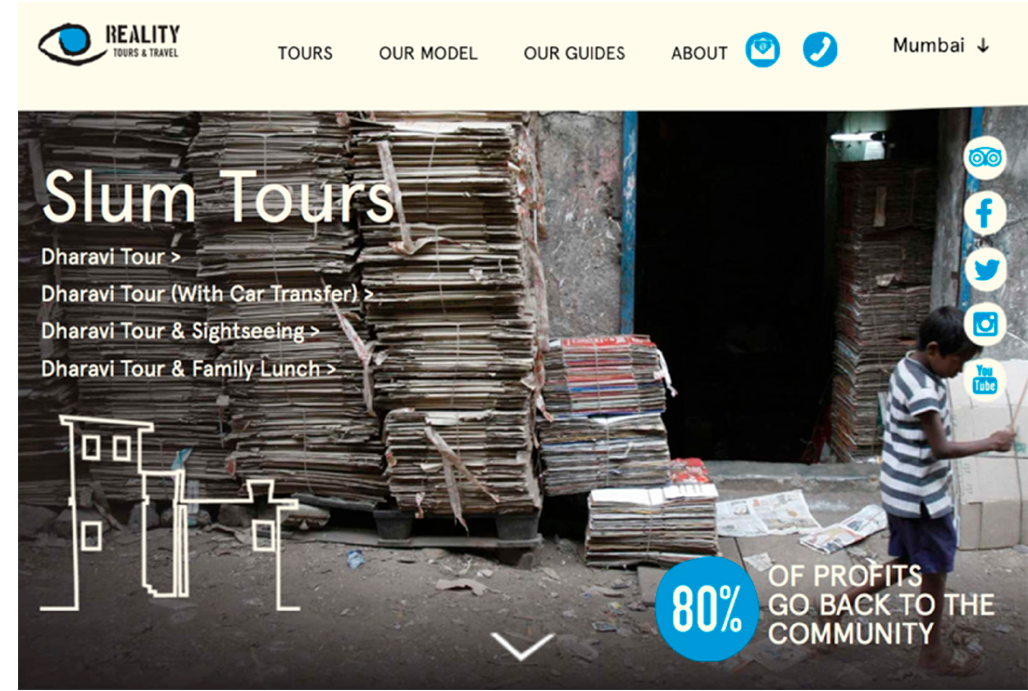
Figure 9. Reality Tours and Travel slum tours webpage [200].